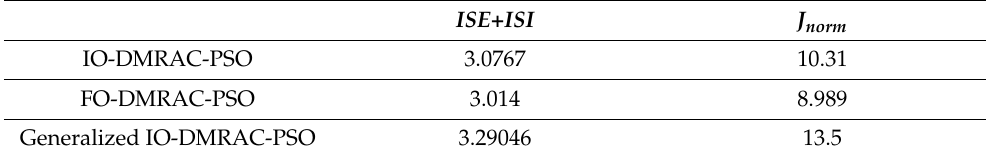
Table 7. J norm cost function using PSO for IO-DMRAC and FO-DMRAC.